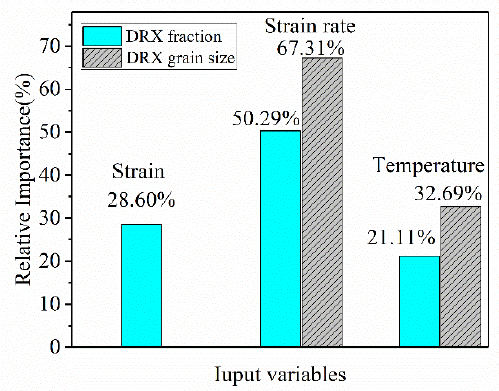
Figure 9. The importance of each variable in the DRX process.